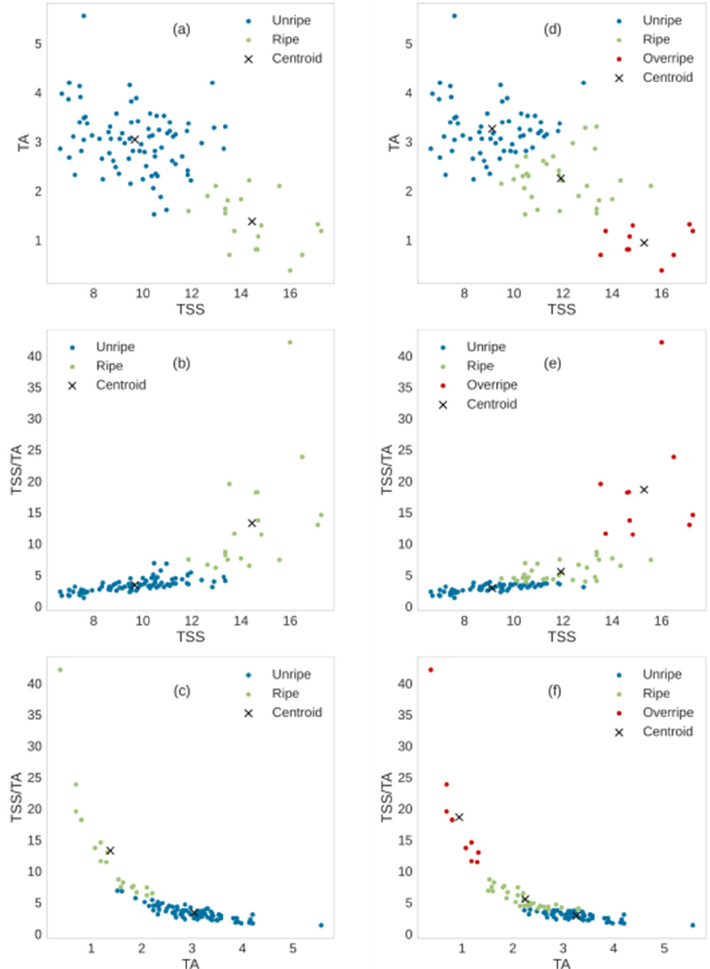
Figure 5. The results from the k-means algorithm on biochemical data of 100 mangoes with k = 2 ( a – c ) and k = 3 ( d – f ): ( a , d ) TSS versus TA; ( b , e ) TSS versus TSS/TA ratio; ( c , f ) TA versus TSS/TA ratio. The symbol colors represent different clusters: unripe = blue, ripe = green, and overripe = red. The mean value (centroid) for each cluster is shown as cross.